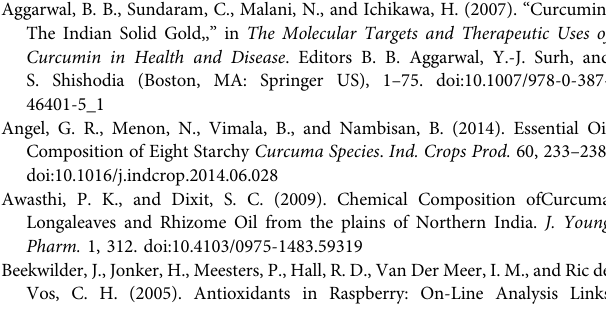
spp. along with the methods used in previous literature.